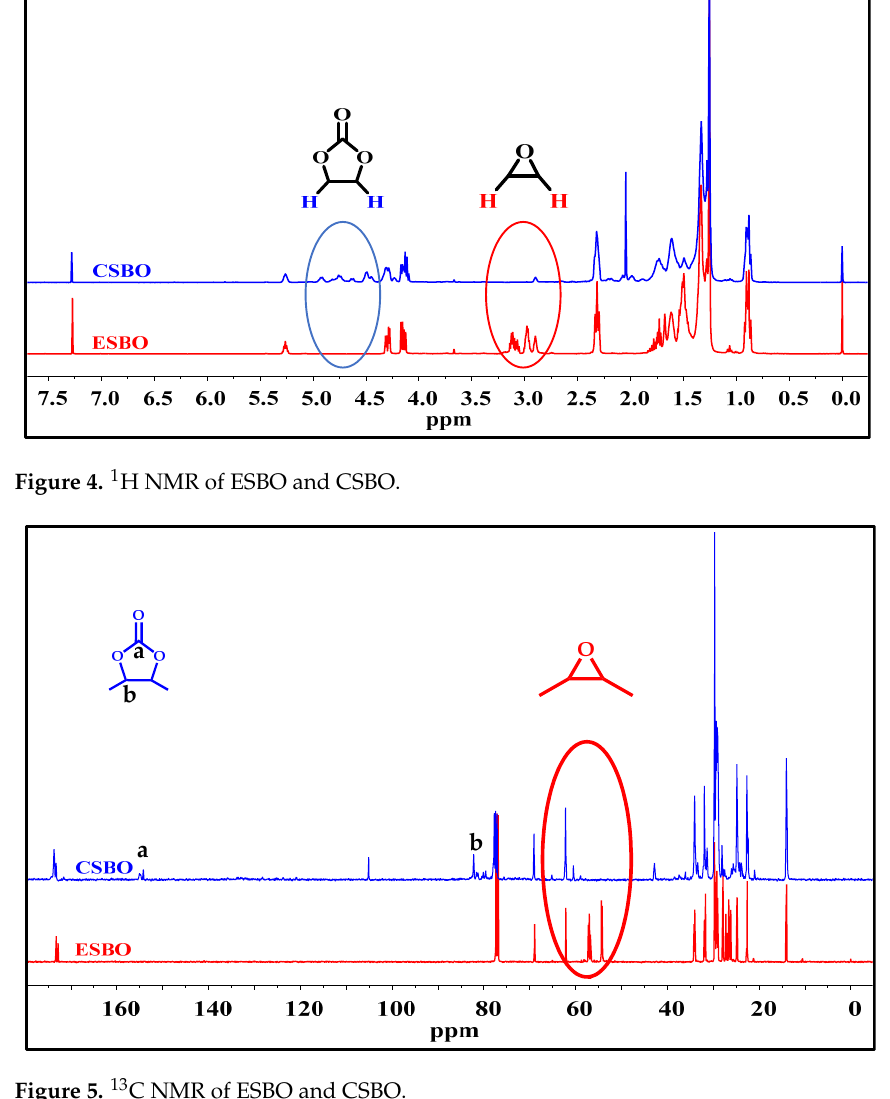
Figure 7. ATR-FTIR of NIPU Composite Film . 3.3.2. Thermal Properties The TGA analysis of NIPU composite films was carried to understand its thermal stability and degradation trend with respect to the temperature increase from 30 to 600 °C at a rate 10 °C/min. The initial degradation from 180 to 265 °C may be related to the dis- sociation of urethane linkages while weight loss from 266 to 440 °C may correspond to decomposition of the long alkyl chains of soyabean oil. Thermal degradation of the poly- meric chain due to C–C and C–O bond scission occurs at approximately 440–520 °C. The 5% and 50% degradation temperature (T d ) of the different composite film are shown in Table 3 and it was observed that there is no effect of TANI loading on the thermal stability of NIPU coatings. It was observed that the % residue of the composite film at 550 °C in- creased with TANI loading. Table 3. Thermal Degradation Data of NIPU Composites . Sample Code